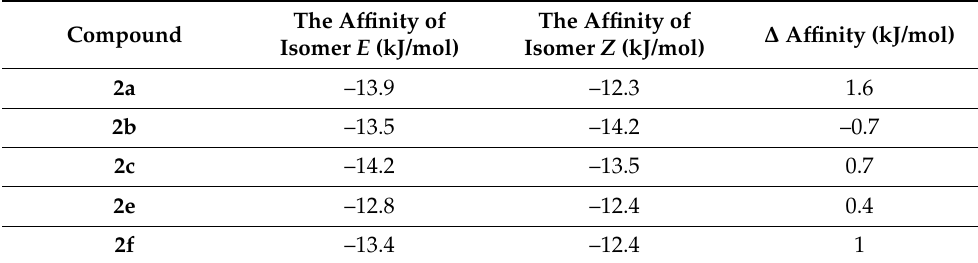
Table 1. Estimated binding free energy ( kJ/mol ) of 2a–2c and 2e–2f , isomers E and Z .